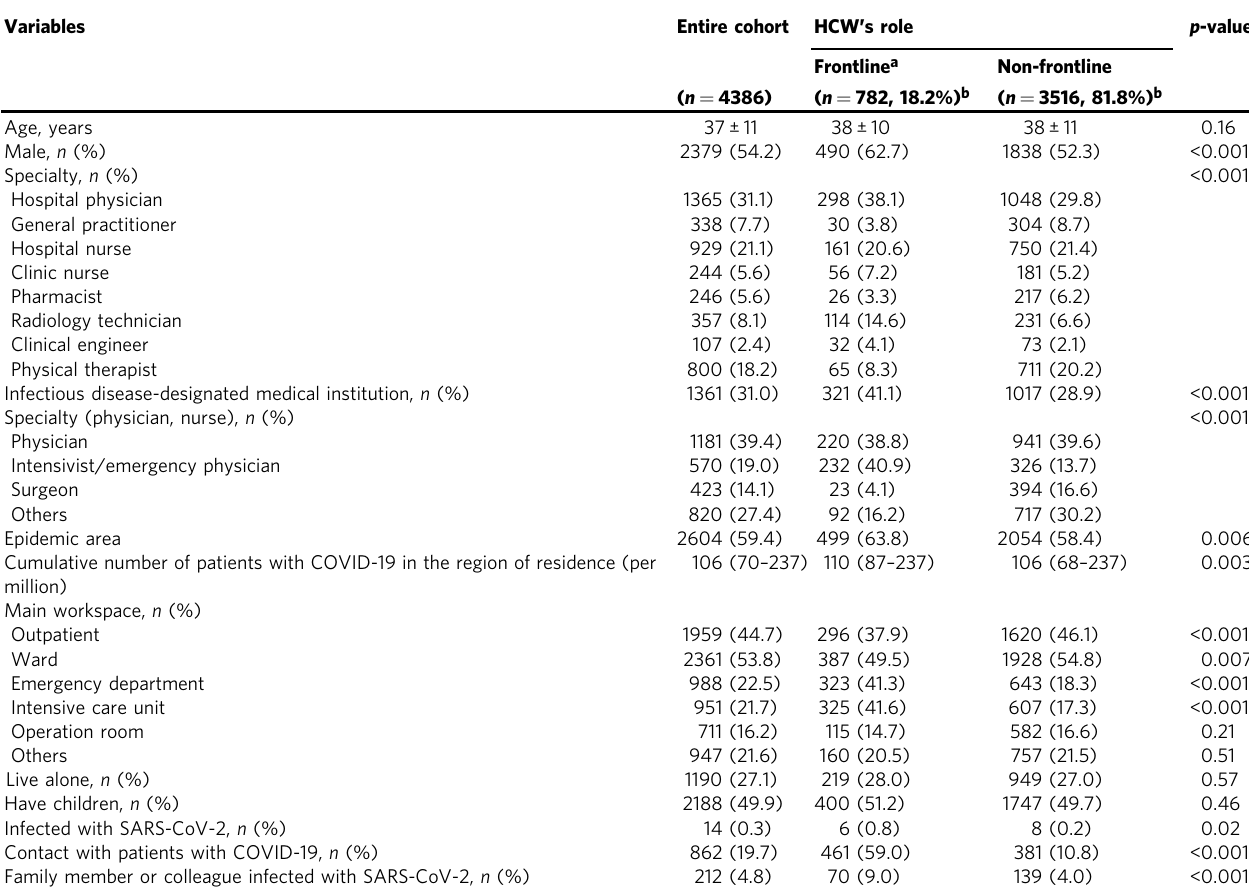
Table 1 Baseline characteristics of study participants ( n =